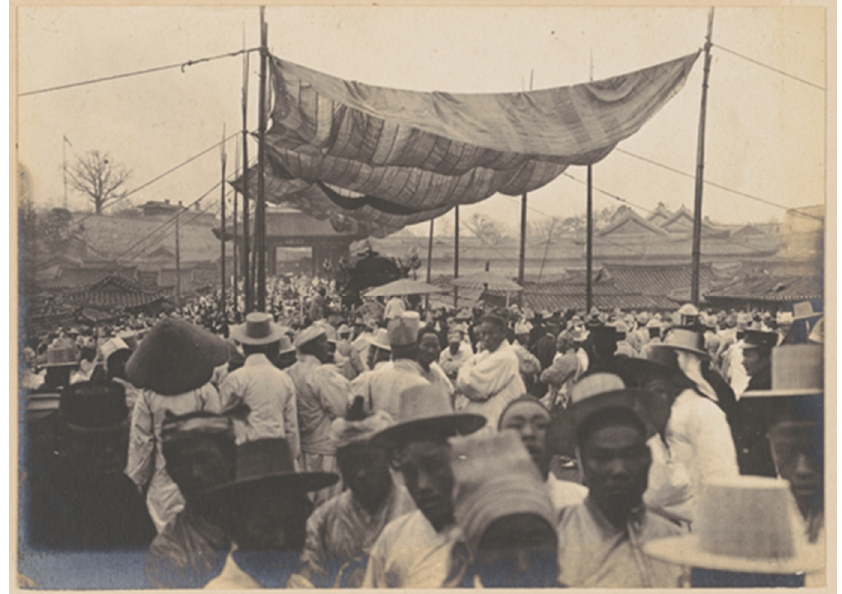
Figure 6. Yŏngsŏngmun (Min Yŏnghwan’s state funeral procession). 1905. Photograph. Willard Dickerman Straight papers, #1260. Courtesy of the Division of Rare and Manuscript Collections, Cornell University Library.